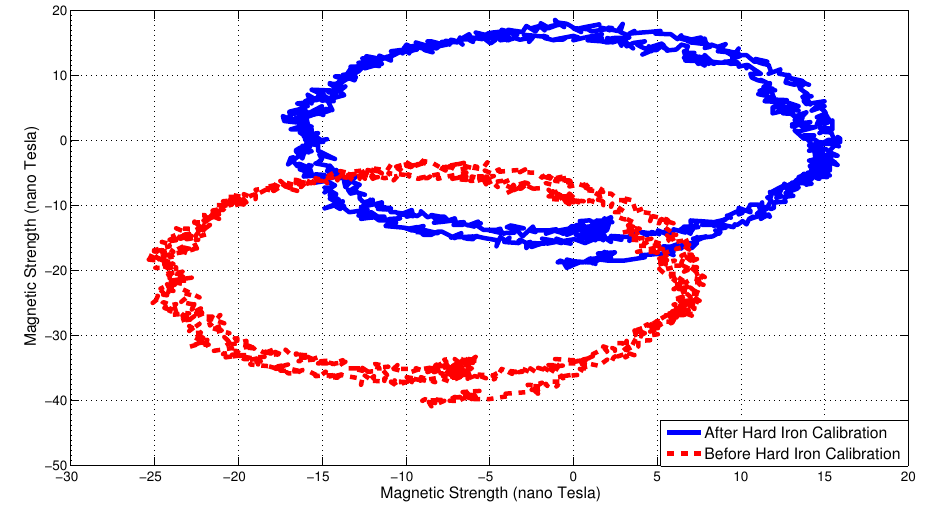
Figure 9. Hard iron errors are calibrated by a 360 ◦ horizontal rotation.